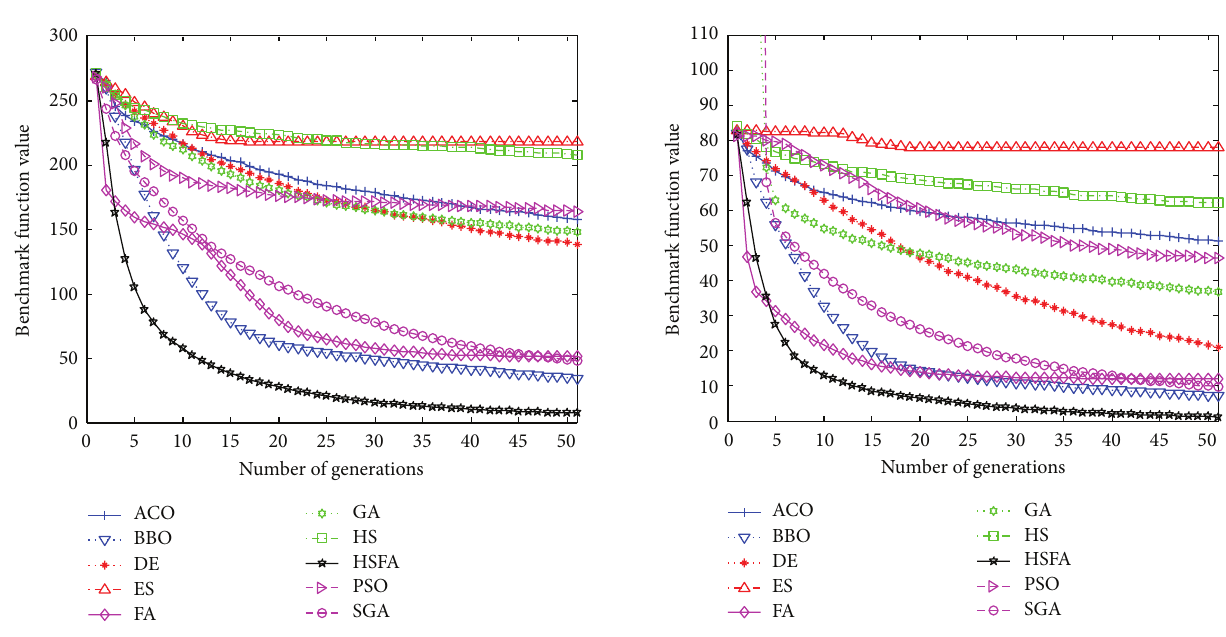
Figure 3: Performance comparison for the F30 Schwefel 2.22 function.